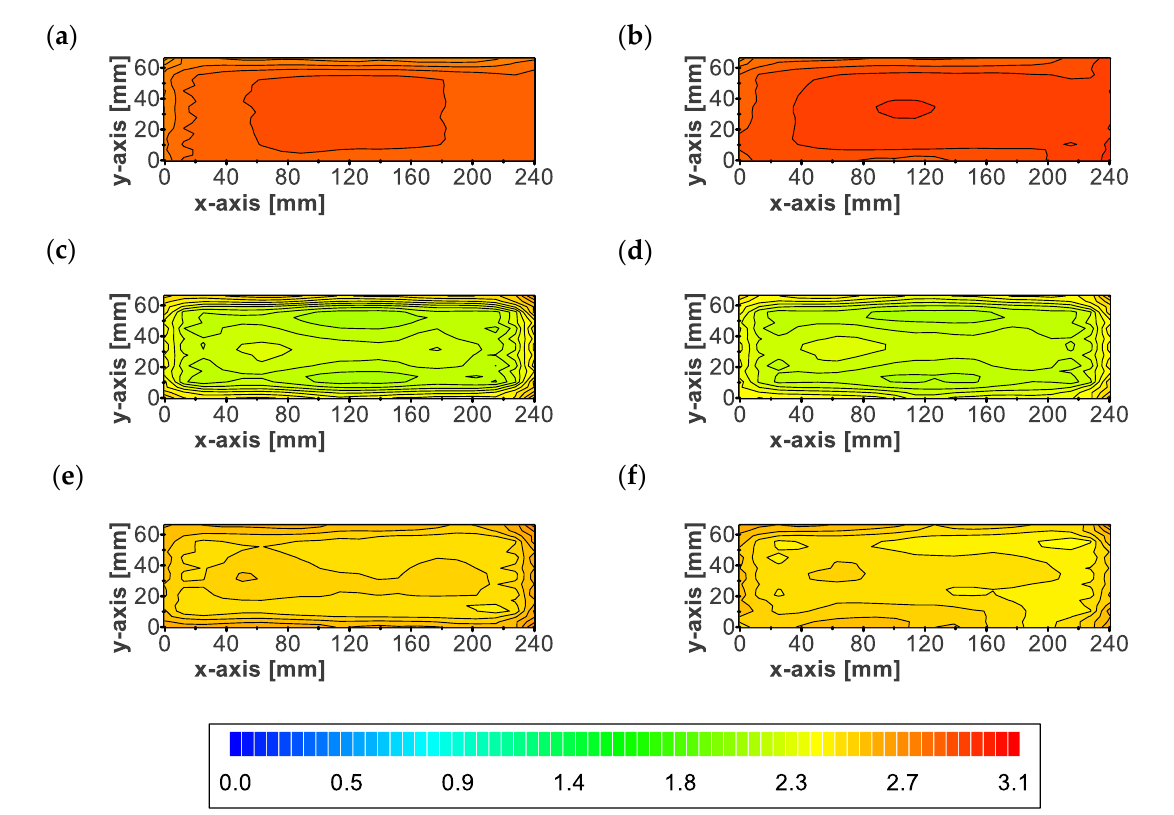
Figure 9. Local percentage thickness increase in pouch cells in % from 0% to 100% SOC averaged over two repetitions. ( a ) F1. ( b ) F2. ( c ) A1. ( d ) A2. ( e ) B1. ( f )